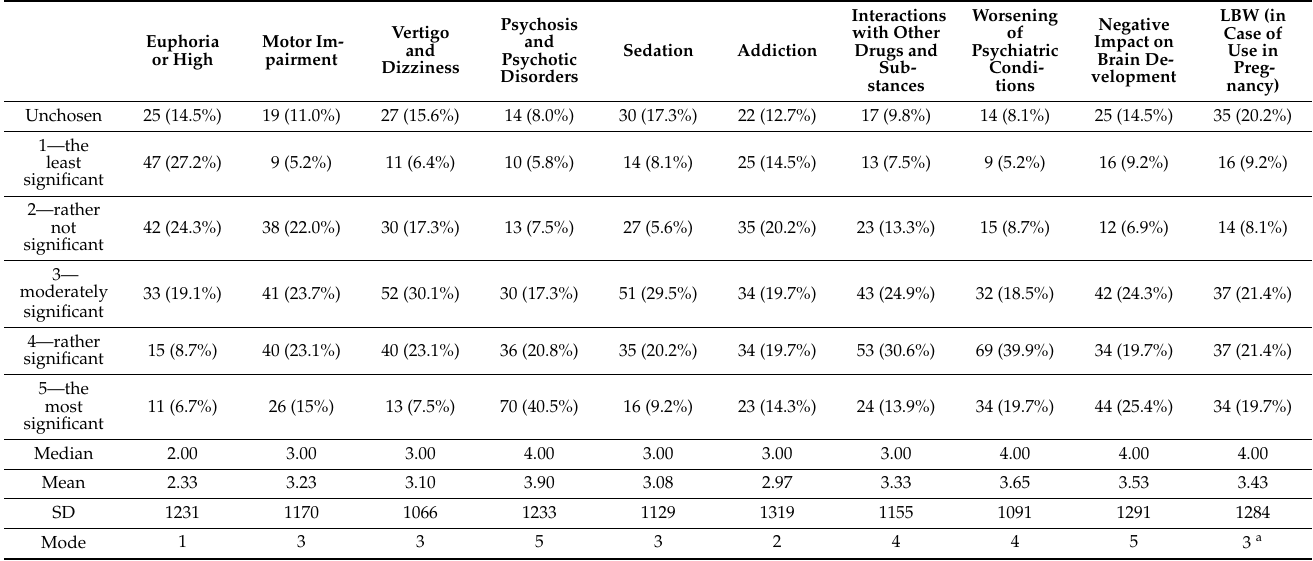
Table 5. Clinical significance (and level of) of potential adverse effects of